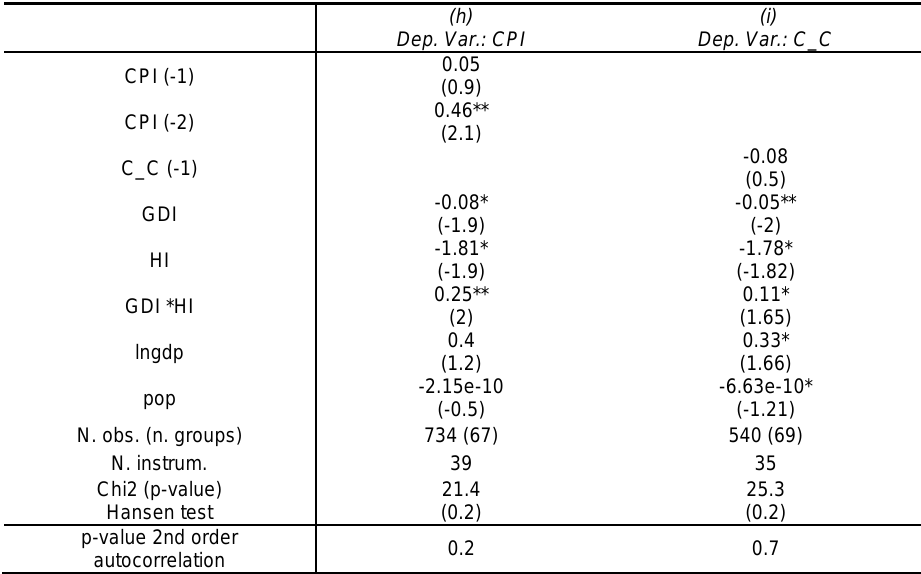
Table 3. Estimations. Dependent variables: CPI and C_C